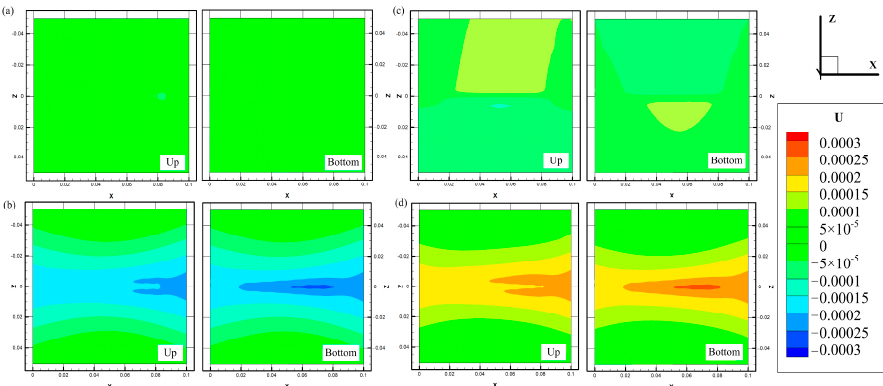
Figure 10. Residual deformation of the whole weld sample: ( a ) Ux, ( b ) Uy, ( c ) Uz, and ( d ) Usum. 11